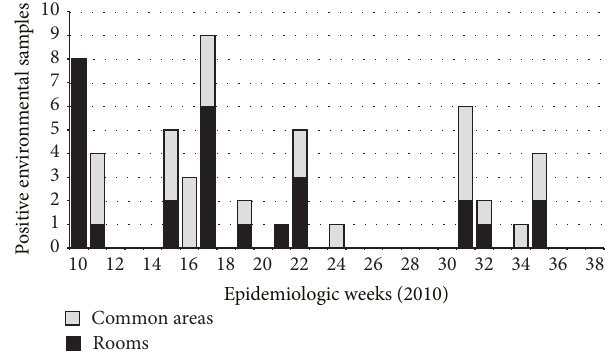
Figure 3: Number of positive environmental samples taken from rooms and common areas in the hospital critical care area, during de second part of the outbreak (2010). After the 36th week of 2010, all the environmental isolates were negative.